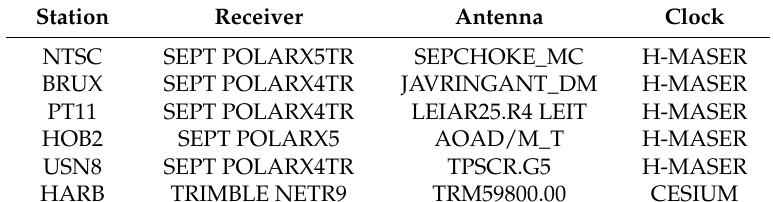
Table 1. The summary of the selected stations from timing laboratories.